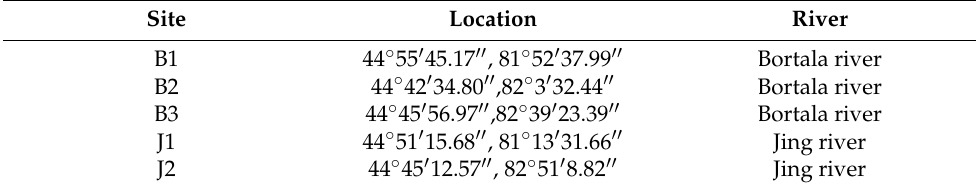
Table 2. Distribution position of river-course